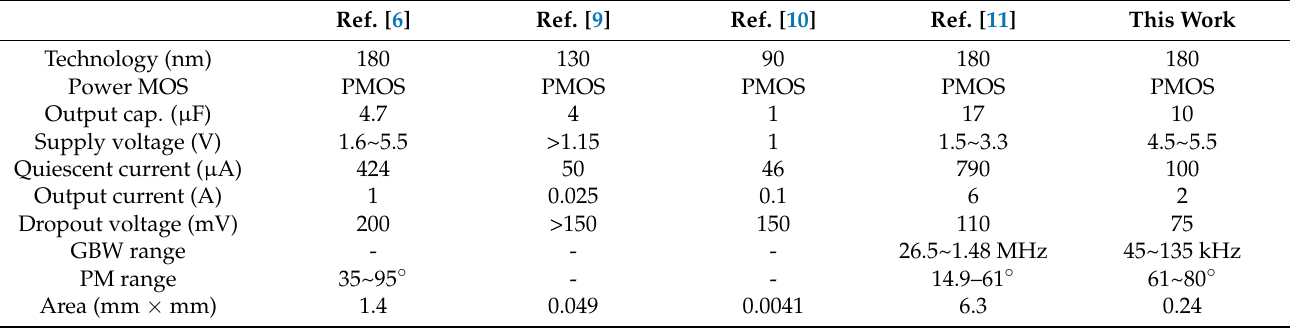
Figure 9. Measurement output voltage V O and output current I O waveforms under load transitions between 0.2 A and 1 A.